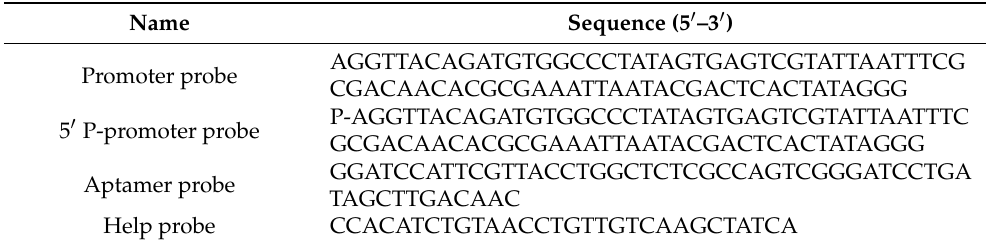
Table 1. Sequences of the oligonucleotides used in this